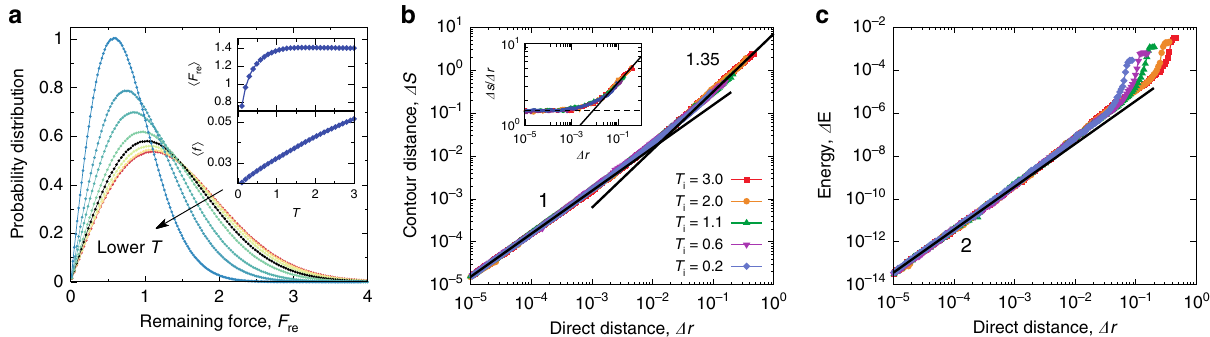
Fig. 2 Giant anharmonic effects in thermal amorphous solids. a Temperature evolution of the probability distributions of rescaled remaining force F re on each particle. F re is de fi ned as the ratio of the remaining force to the average strength of contacting forces, which measures the degree of deviation from the mechanical equilibrium of each particle. Here only particles with at least three contacting neighbours (the minimal requirement for local stability) are counted. We con fi rm that the others have little contribution to the stable force network. The same colour bar as in Fig. 1b is used. The data set corresponding to the hypothesised ideal glass transition temperature T 0 ≈ 0.63 is highlighted in black colour as a reference. The lowest temperature is T = 0.1 in this plot. Inset: Temperature dependence of the average rescaled remaining force h F re i (top) and the globally averaged strength of force bonds 〈 f 〉 i remains in the order of 1 even deep in the solid phase. b , c Characterisation of the potential energy landscape. Finite-temperature (bottom). Note that h F re con fi gurations, which correspond to the top-right end of each curve, are relaxed to the inherent states (IS) using energy minimisation (EM) methods. b Relationship between contour distance Δ s and direct distance Δ r with respect to IS during EM for different initial temperatures T i . Power-law fi ts are labelled by their corresponding exponent. We can see a crossover from a linear relation Δ s ~ Δ r close to IS to a fractal one Δ s ~ Δ r 1.35 away from IS. Inset: Δ s / Δ r verse Δ r replotted using the data from the main panel. The crossover from Δ s ~ Δ r (dashed line) to Δ s ~ Δ r 1.35 (solid line) is more evident in this plot. c Relationship between energy Δ E with respect to IS and Δ r . The solid black lines indicate the quadratic (harmonic) relation Δ E ~ Δ r 2 . Here the ensemble of con fi gurations generated by a cooling rate γ = 10 − 5 is used for analyses, but the results are insensitive to the choices of γ . All these analyses indicate that the thermal systems in physically relevant temperatures (e.g., T i = 0.2 ~ 3.0 in ( b ) and ( c ) are completely out of the harmonic